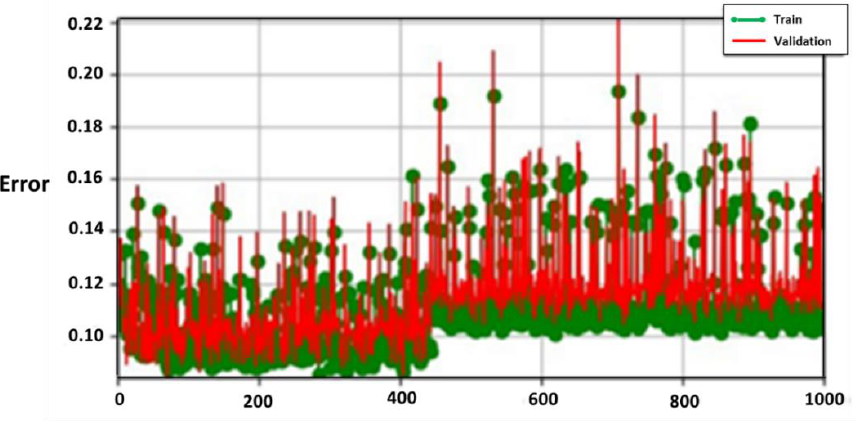
Figure 7. Neural network learning curve.